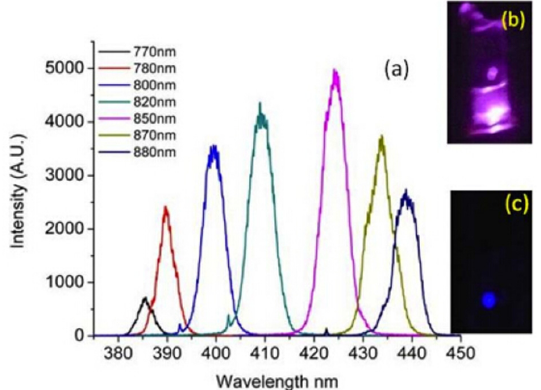
Figure 3. ( a ) Second harmonic spectral profile from ZnO NPs under various laser excitations. ( b ) SHG emission from ZnO NPs dispersed in water and irradiated by 840 nm laser source. ( c ) SHG emission at 420 nm with a blue filter. Reprinted with permission from reference [80]. Copyright 2012 Wiley-VCH Verlag GmbH & Co. KGaA.